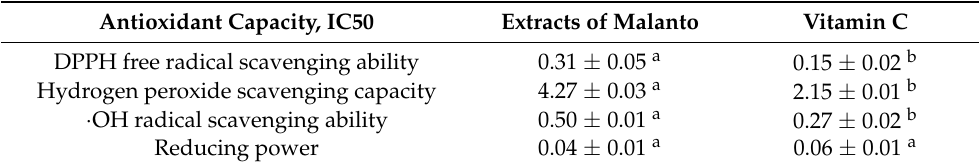
Table 2. In vitro antioxidant capacity (half maximal inhibitory concentration, IC50) of bioactive substances from extracts of